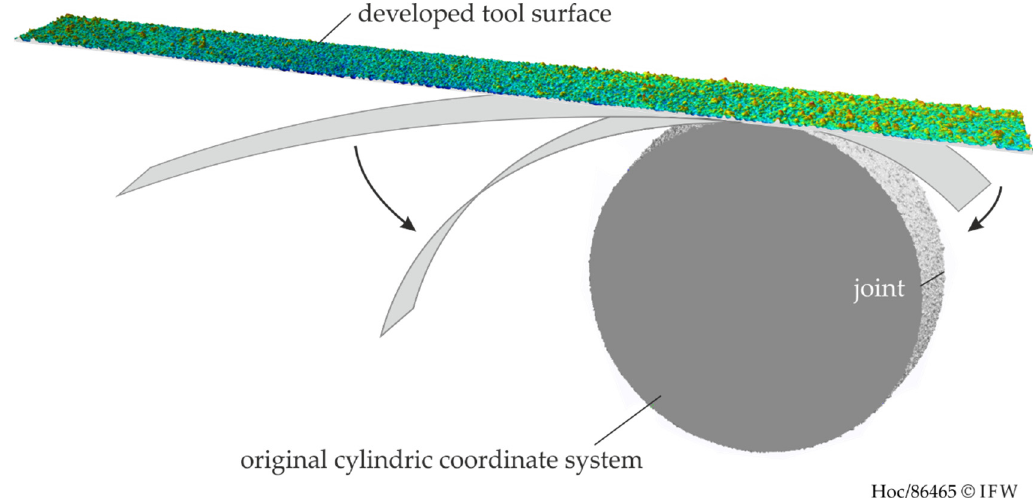
Figure 3. Retransformation of the tool topography in original cylindrical coordinate system.